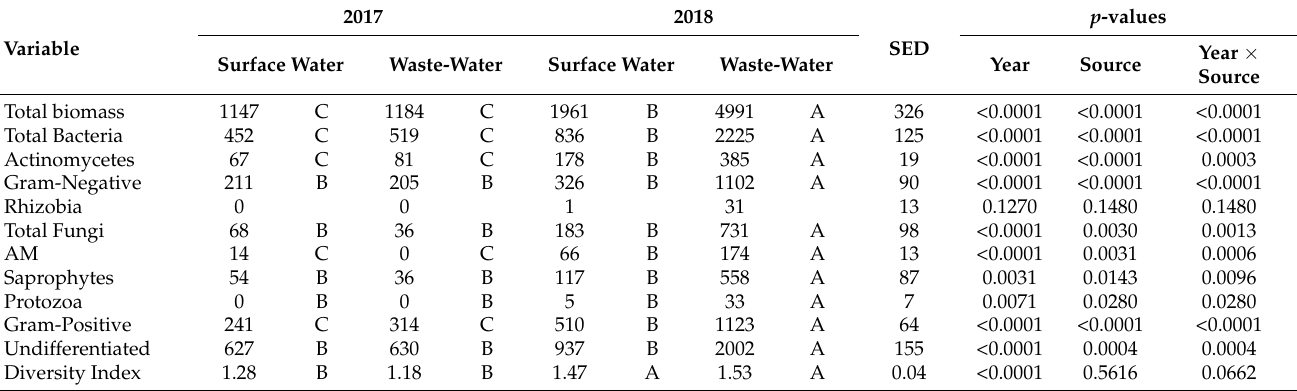
Table 4. Soil microbial biomass (nmol g − 1 ) and diversity index before and one year after alfalfa establishment when irrigated with surface water or treated municipal wastewater (Class 1B, UV- irradiated) at Tucumcari, NM, USA. Values are the means of four replicates within each water source strip plot each